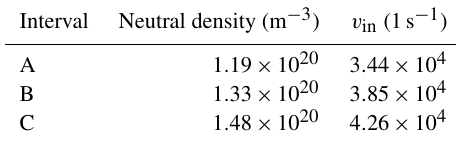
Table 3. Neutral density for each interval from NRLMSISE-00 at- mosphere model (Hedin, 1991) taken at 21:00UT and the estimated ion-neutral collision frequency (see Ieda, 2020; Cho et al., 1998).